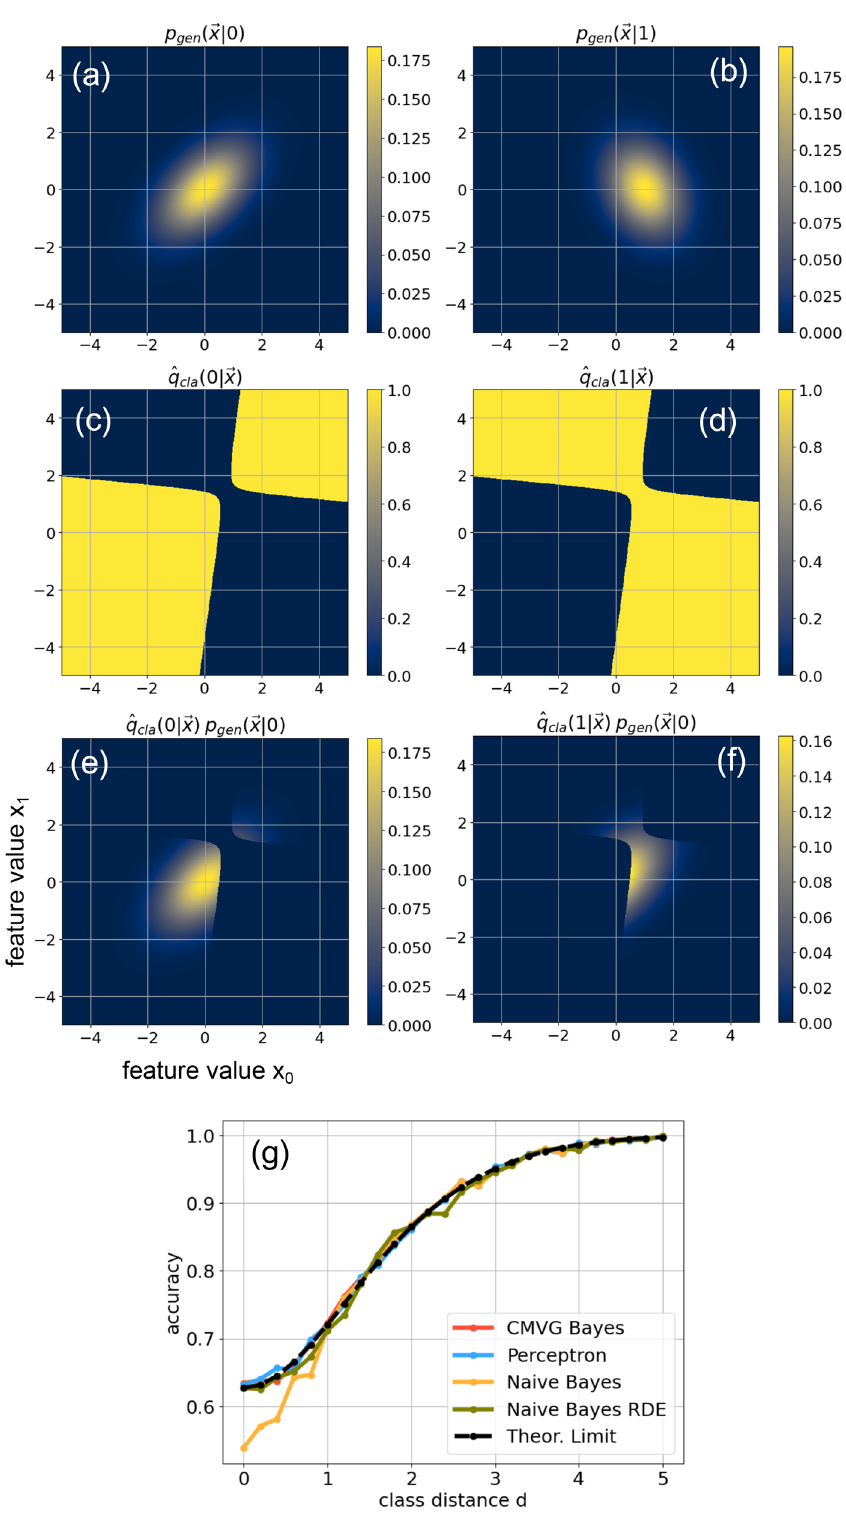
Figure 3. Theoretical limit for classification accuracy. We consider two classes i ∈ { 0, 1 } in a two-dimensional feature space (cid:31) x . The first row shows the probability densities p gen ( � x | i ) that data point (cid:31) x is generated under class i = 0 ( a ) or class i = 1 ( b ). The second row shows the binary probability distributions ˆ q cla ( j |� x ) ∈ { 0, 1 } that data point (cid:31) x is assigned to class j = 0 ( c ) or class j = 1 ( d ), assuming a perfect classifier. The third row shows the ’confusion densities’ ˆ q cla ( j |� x ) p gen ( � x | i ) that data point (cid:31) x is generated under class i = 0 and assigned to class j = 0 ( e ) or class j = 1 ( f ). Integrating this density over (cid:31) x yields the confusion matrix C ji , from which the classification accuracy A can be computed. Panel ( g ) in the fourth row shows the maximum possible classification accuracy (black curve) when the distance d between the centers of the two data classes ( a ) and ( b ) in feature space is increased from 0 to 5. All classifier models considered in this paper (colored curves), except the Naive Bayes model (orange) at small distances, reach the theoretical accuracy